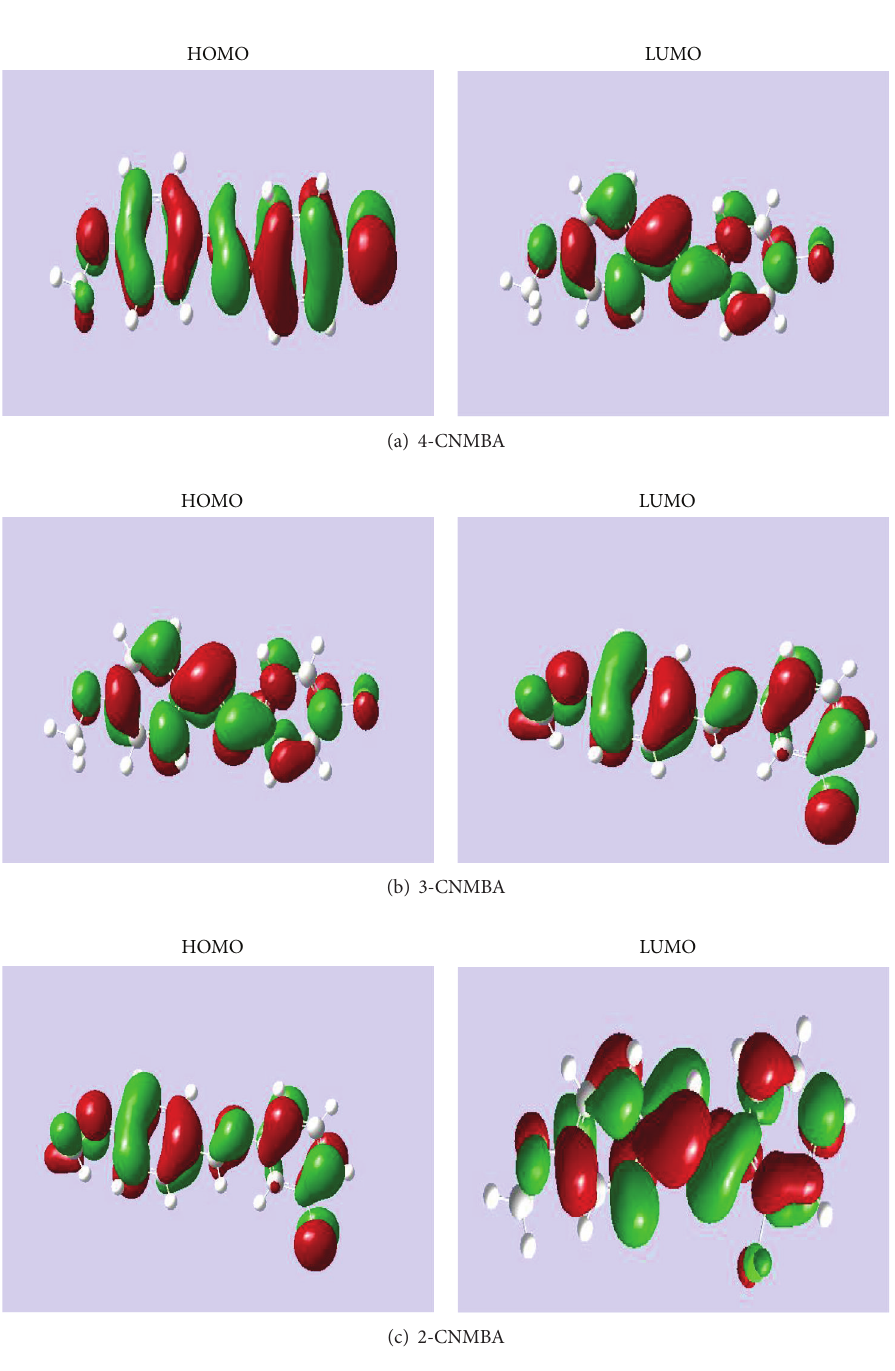
Figure 4: HOMO and LUMO diagrams of studied compounds using B3LYP/6-31+G(d)